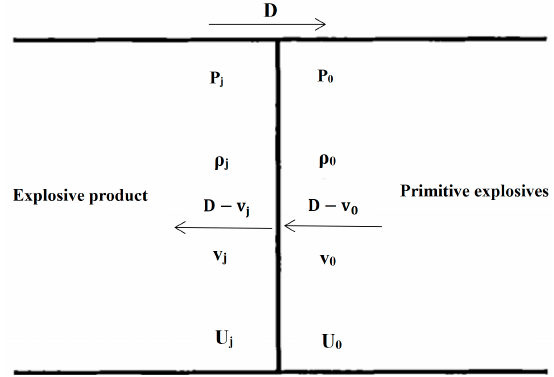
Figure 2. CJ detonation wave model.